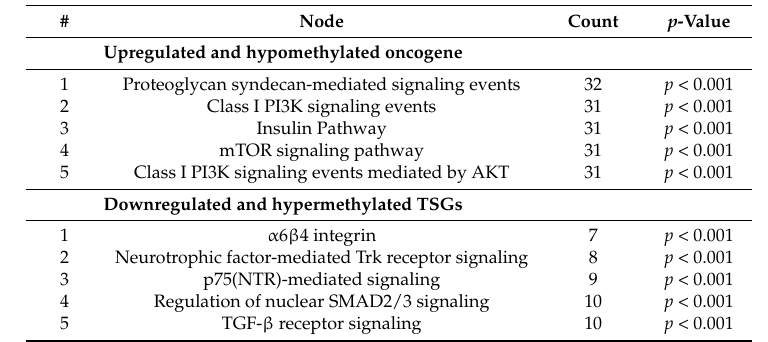
Table 1. The pathways in which the three oncogenes and the four tumor suppressor genes (TSGs) were mainly involved.